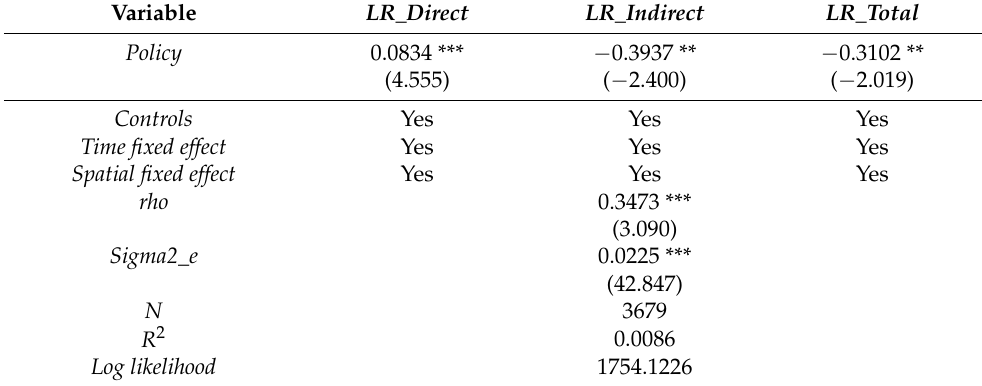
Table 7. Spatial effect decomposition results of the DID-SDM